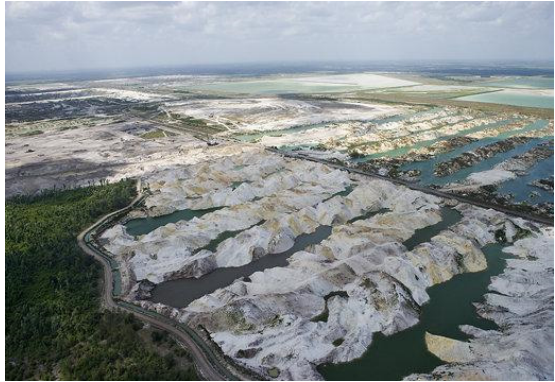
Figure 1. The storage condition of PG in Florida.